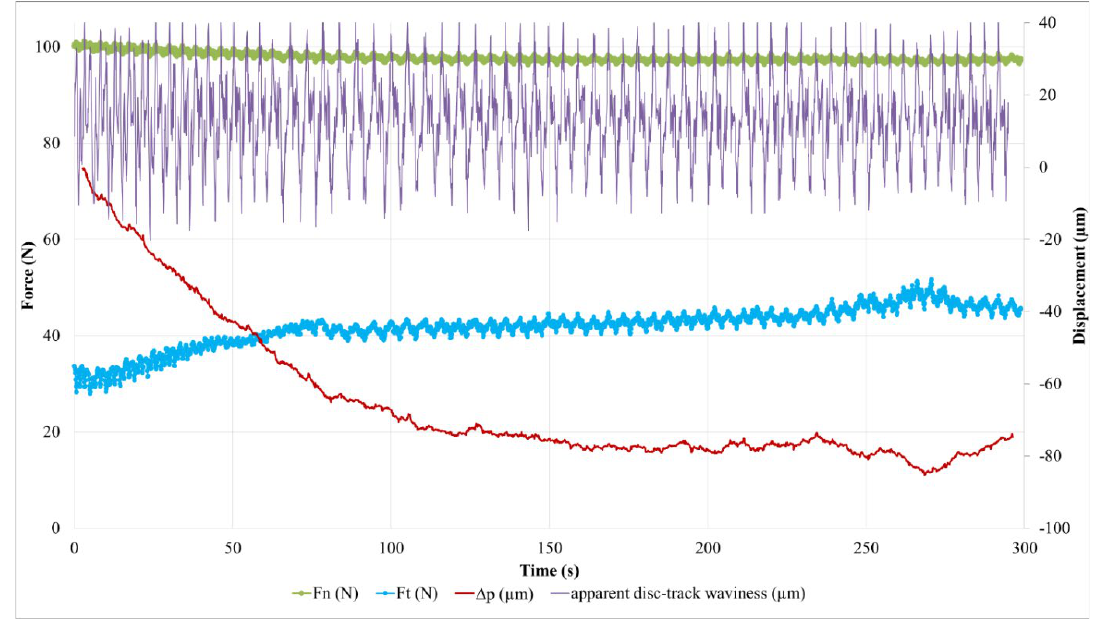
Figure 13. Evolution of contact forces, pin displacement (∆p) and apparent disc track waviness dur- ing the friction test for material M1.